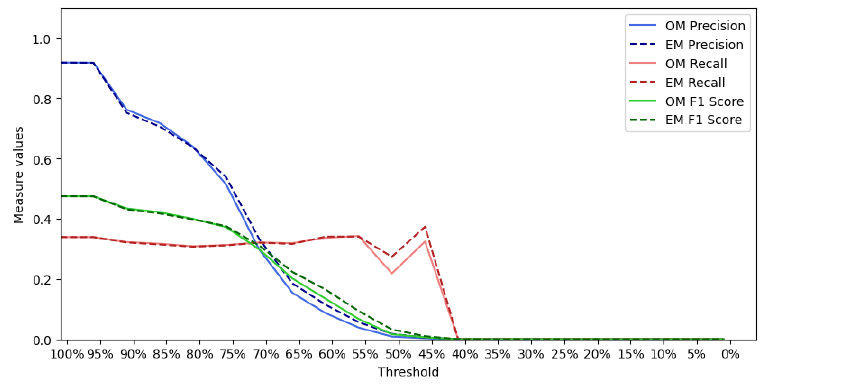
Figure 20. All Tweets from PHEME dataset by threshold.